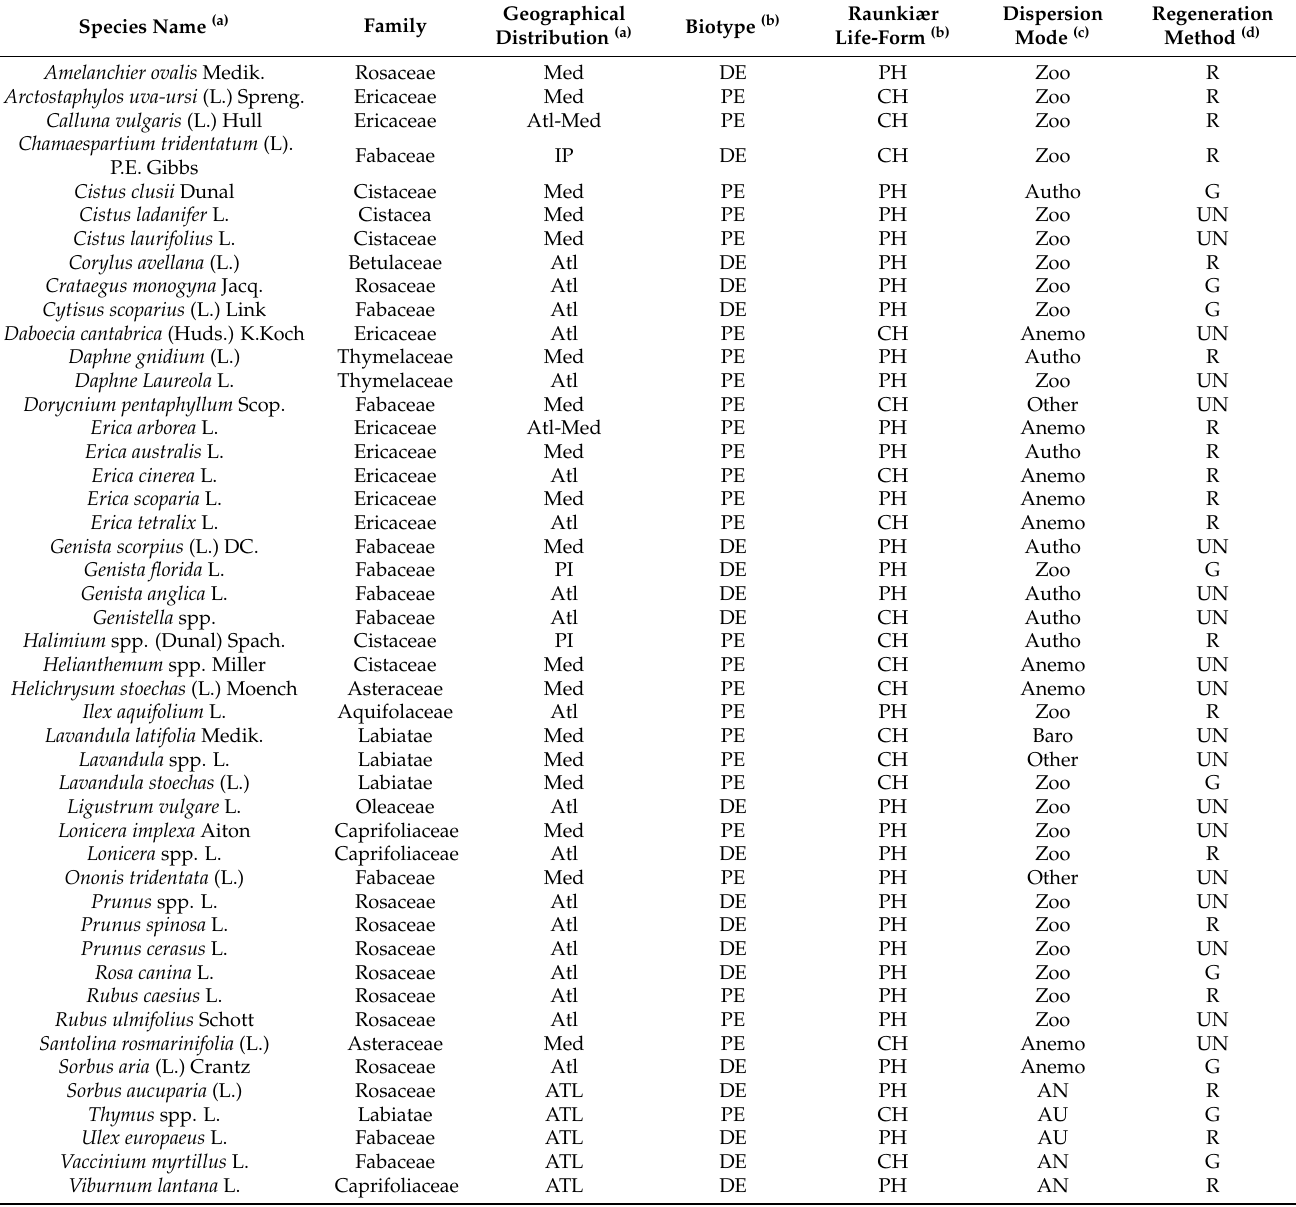
Table A1. Different characteristics of shrub species used for HOF modeling along the two main coenoclines. Abbrevi- ation: Atl = Atlantic; Med = Mediterranean; Atl-Med = Atlantic and Mediterranean; IP = endemic of the Iberian Penin- sula; DE = deciduous; PE = perennial; CH = Chamaephyte; PH = Phanerophyte; AU = authochory; Baro = Barochory; Zoo = zoochory; Anemo = Anemochory; other = other dispersion mode; R = resprouter; G =